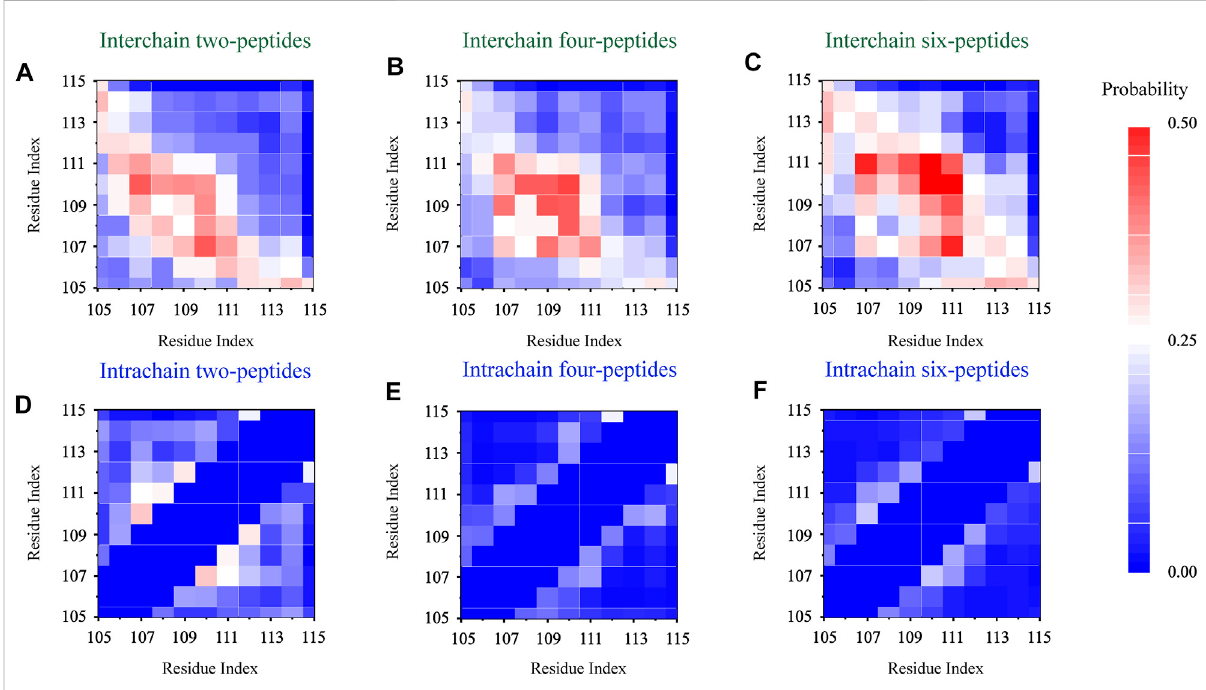
FIGURE 5 Residue-residue interaction analyses. The interchain and intrachain residue-residue contact probabilities for each simulation of thetwo- (A,D) , four- (B,E) , and six- (C,F) peptides,